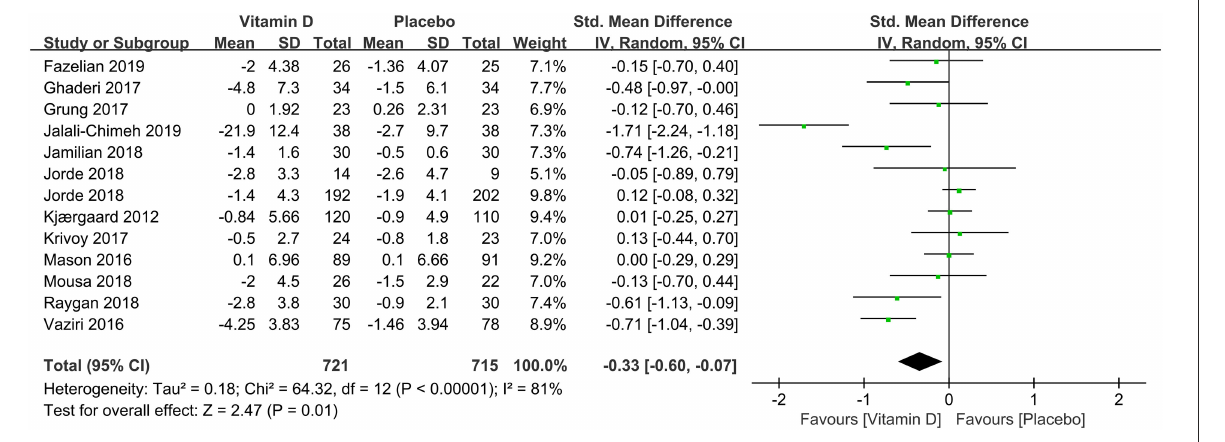
doses ( > 2,800 IU/day) of vitamin D supplementation